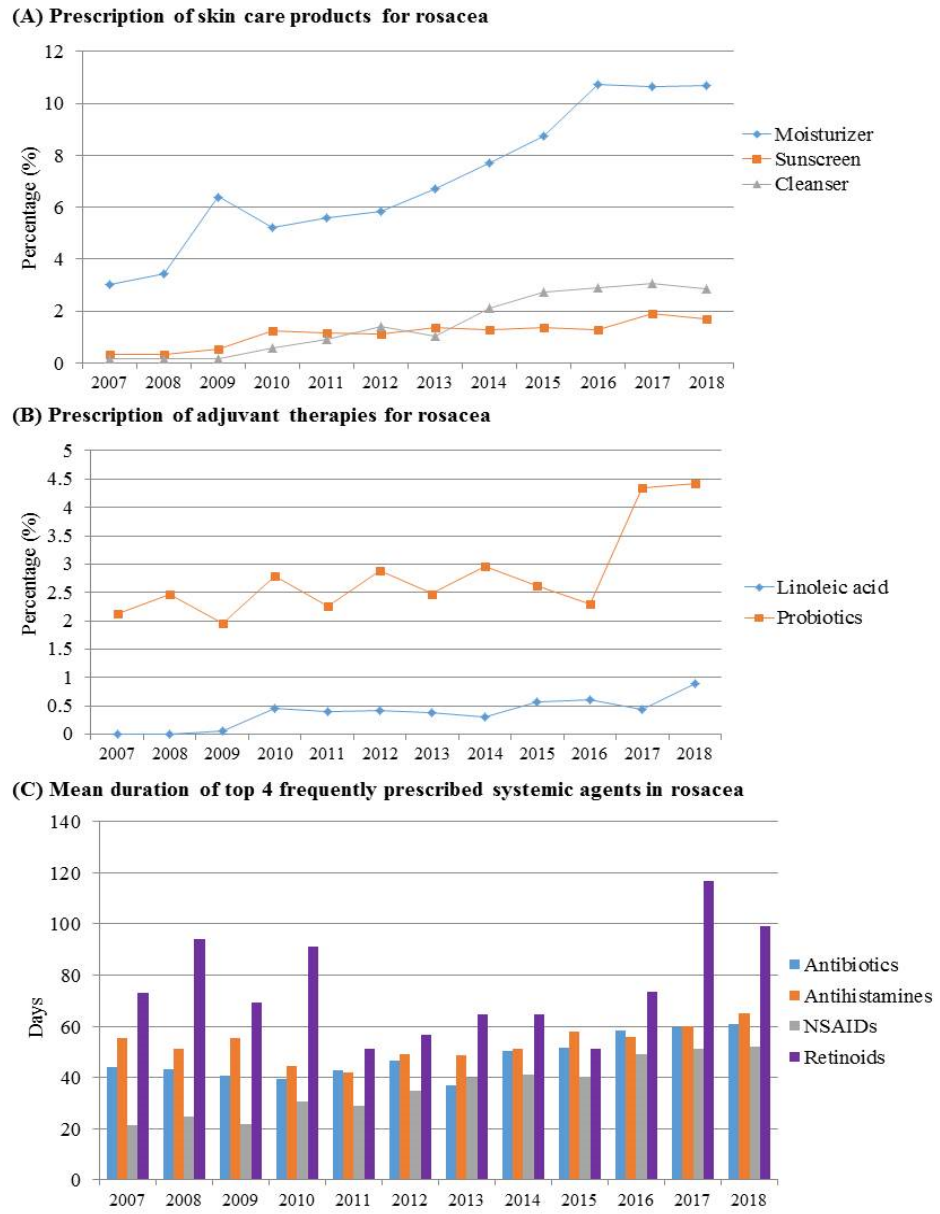
Figure 4. Prescription trends of skin care products and adjuvant therapies. ( A ) Prescription of skin-care products for rosacea. ( B ) Prescription of other adjuvant therapies for rosacea. ( C ) The mean duration of top 4 frequently prescribed systemic agents for rosacea.